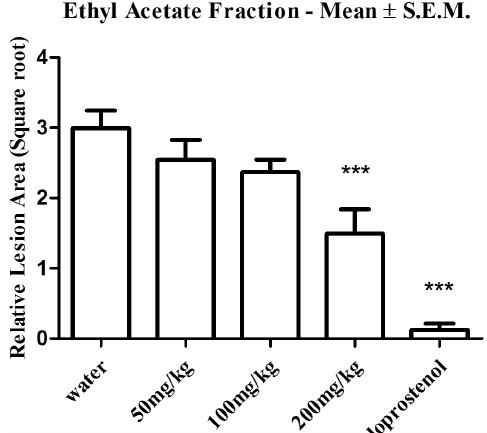
FIGURE 2 - Effect of the ethyl acetate fraction from Kalanchoe pinnata leaves on the ethanol/HCl-induced gastric model in Wistar rats. Relative lesion area is presented as the mean ± S.E.M.; n=7 for each group. ANOVA was carried out and followed by Dunnett's test, *** p < 0.001 compared to